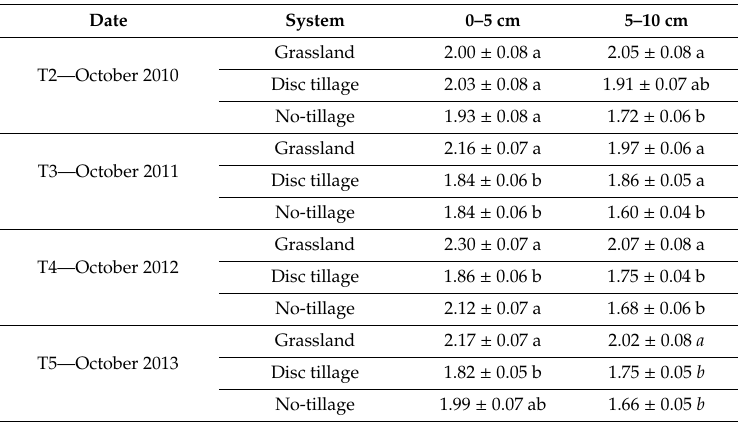
Table 2. Soil carbon content (% dry matter) measured in three agricultural systems. Means are followed by standard error ( n = 24). Letters indicate a statistical di ff erence between systems computed with a Tukey test at p < 0.05. Italic letters refer to nonparametric analysis (Kruskal–Wallis test). See Perrin et al. [40] for